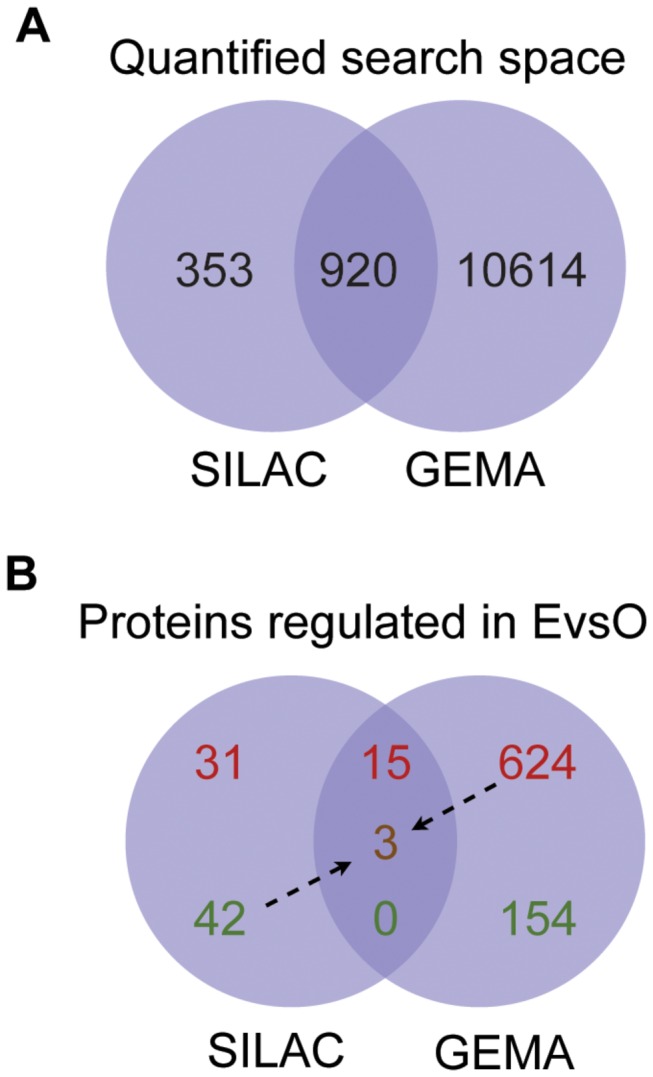
Search space comparison of genes and proteins for the comparison of EvsO differentially expressed genes/proteins in SILAC and GEMA.Panel A. Comparison of search spaces containing all genes/proteins quantified in SILAC and GEMA analyses. Panel B. Numbers of differentially expressed genes/proteins in the EvsO comparison according to method (SILAC fold change >1.3, p-value <0.01; GEMA fold change >1.5, BH-p-value <0.01). Red numbers indicate up-regulations while green indicates down-regulations. The brown number indicates genes/proteins found down-regulated in SILAC while up-regulated in GEMA. In both GEMA and SILAC, 7% of the genes/proteins in the respective search spaces were found to be regulated in the EvsO comparison.